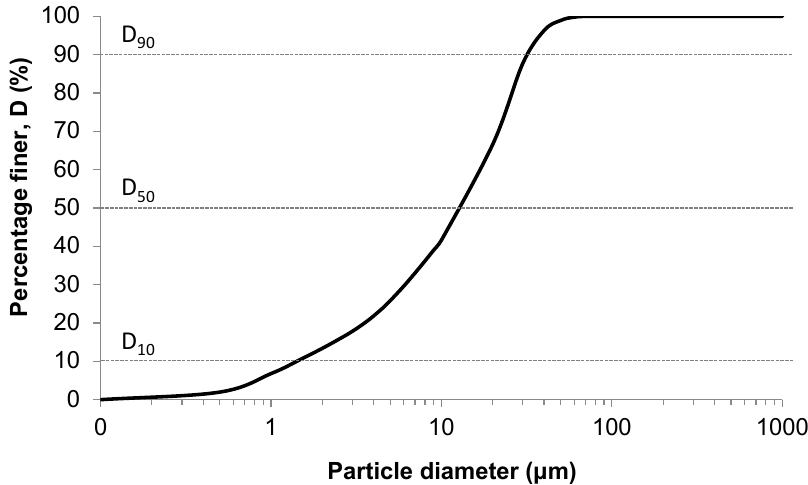
Figure A4. Particle size distribution of GGBFS.